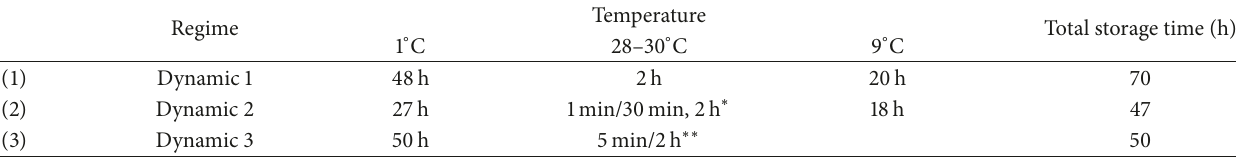
Table 1: Storage conditions of the three dynamic temperature